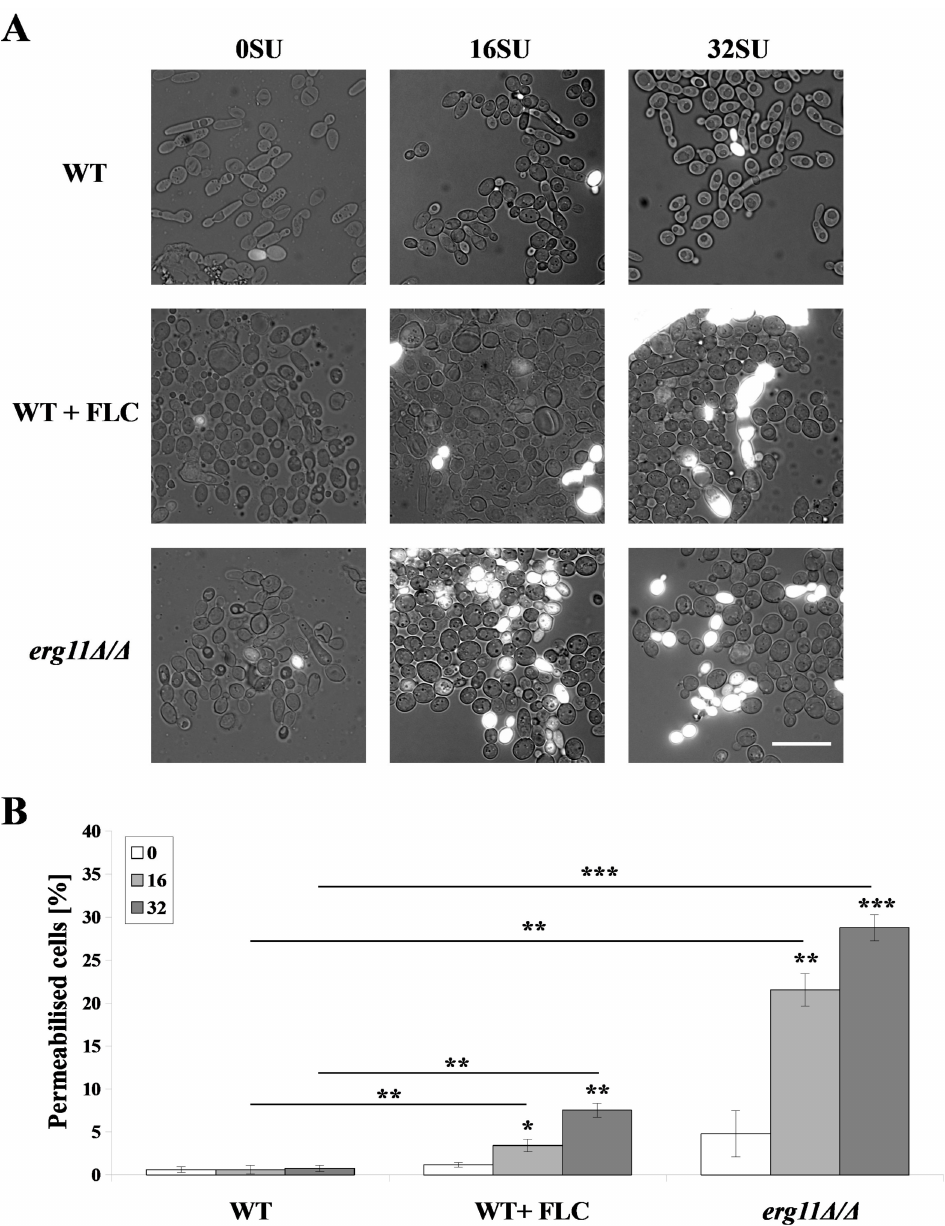
Figure 2. C. albicans CAF2-1 (WT) strains were grown in the presence of 1 µ g / mL fluconazole pretreatment (WT + FLC). C. albicans KS028 ( erg11 ∆ / ∆ ) strains were stained with propidium iodide (PI) after 2 h treatment with SU (0, 16 and 32 µ g / mL). ( A ) Representative microscopic observations, scale bar = 20 µ m; ( B ) Histograms of quantified % of permeabilized cells, means ± SD ( n = 3), statistical analysis at each concentration was performed relative to control experiments without SU treatment (above bars) or between WT and WT + FLC or WT and erg11 ∆ / ∆ strains (above lines) (*, P < 0.05; **, P < 0.01; ***, P <